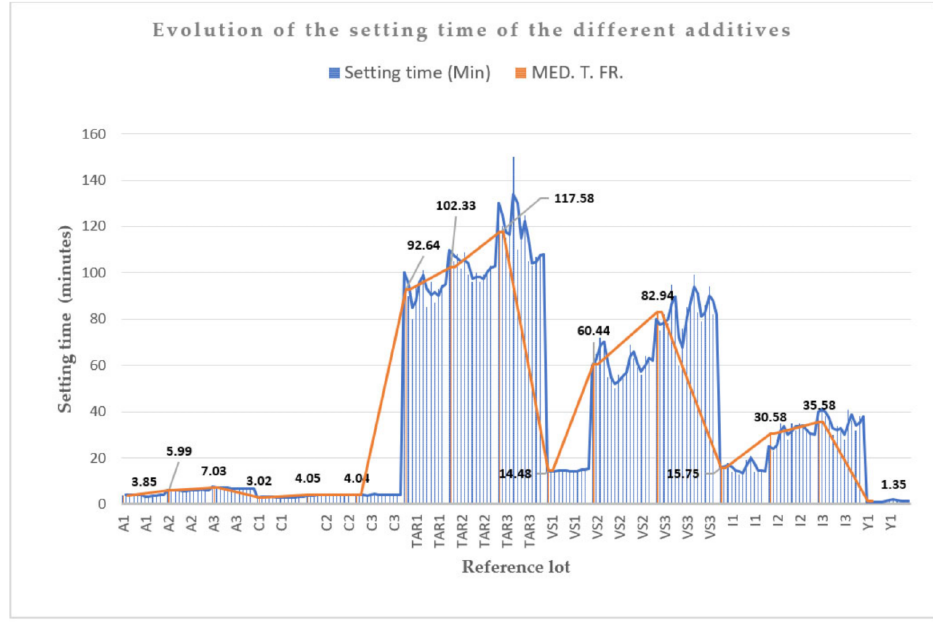
Scheme 1. Evolution of the “setting times” of the different